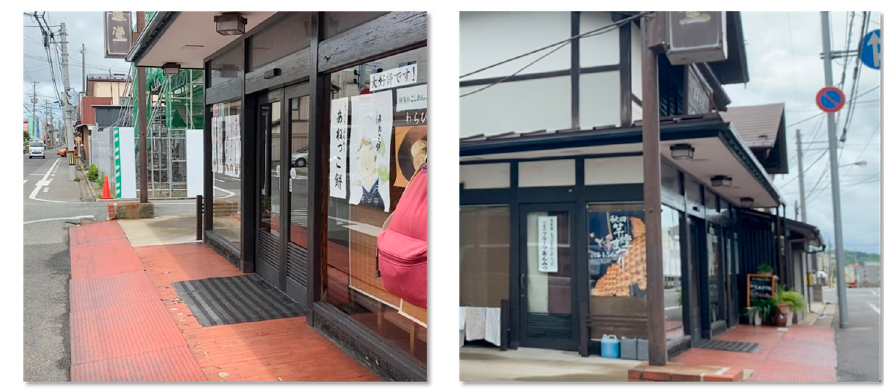
Figure 19. Typical architectural style of a Japanese sweets shop.